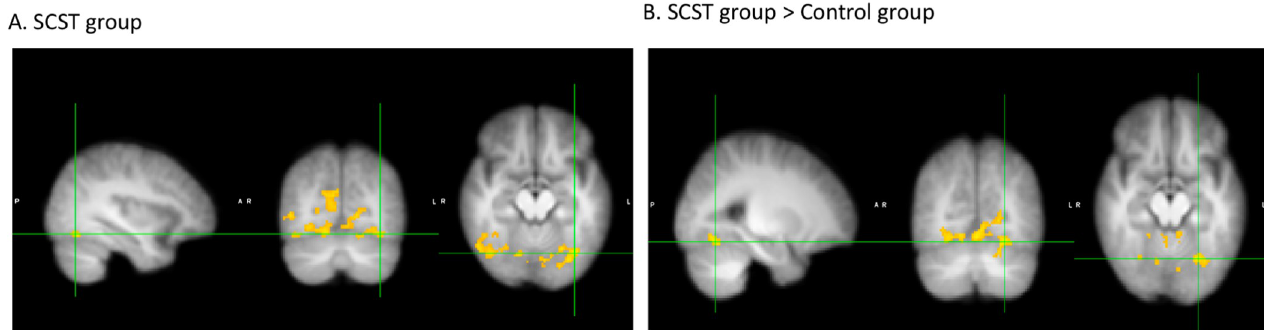
Fig 1. Brain areas that showed significantly increased PPI connectivity during the contrast of [emotion matching > gender matching] during the Facial Affect Matching task at 12 wks compared to baseline. A) brain areas with significant PPI connectivity in SCST group. Cross-hairs centered on MMI coordinates: x = -36, x = -68, z = -14. B) brain areas, in which SCST group showed increased PPI connectivity compared to Control group. Cross-hairs centered on MMI coordinates: x = -26, x = -64, z =